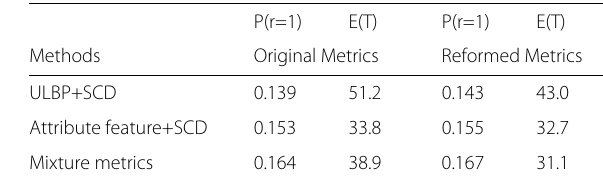
Table 3 Comparison across metrics and